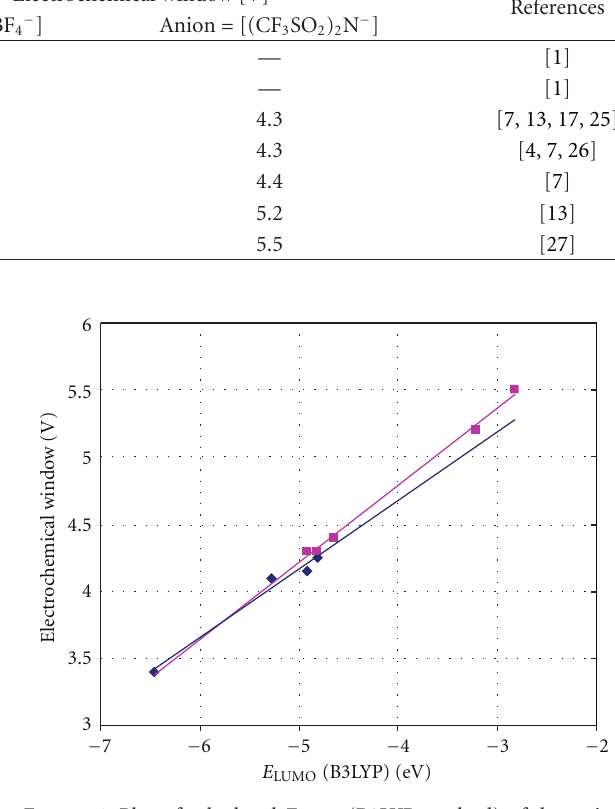
LUMO (B3LYP method) of the cation versus electrochemical window of the ionic liquid: blue: anion BF 4 − ; pink: anion (CF 3 SO 2 ) 2 N − . The correlation coe ffi cients are 0.98 (anion = BF 4 − ) and 0.99 (anion = ((CF 3 SO 2 ) 2 N −